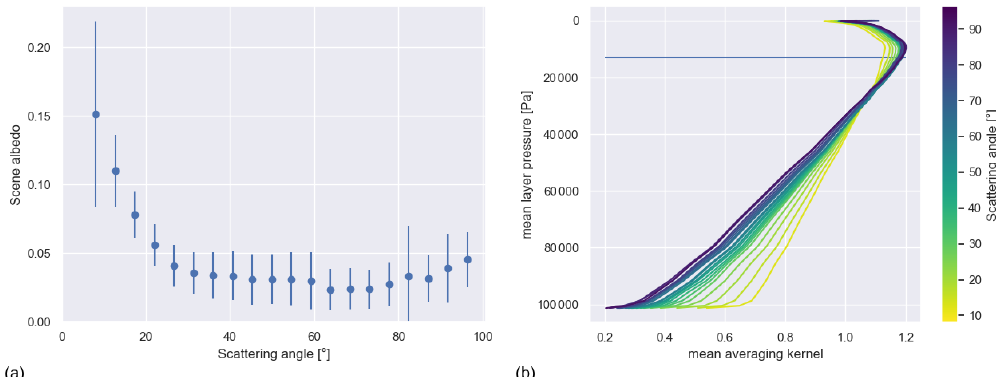
Figure 3. (a) Change in effective scene albedo with scattering angle over the Central Mediterranean north of Libya in June–July–August 2018 (see gray rectangle in Fig. 1c, ≈ 200000 data points in total). The error bars indicate the standard deviation of each bin. (b) Mean averaging kernel (profiles) for different scattering angles, sampled as for (a) . Only pixels with cloud radiance fractions < 0.25 or p surf − p cloud ≤ 300Pa were selected. The blue line in (b) indicates the average tropopause altitude.